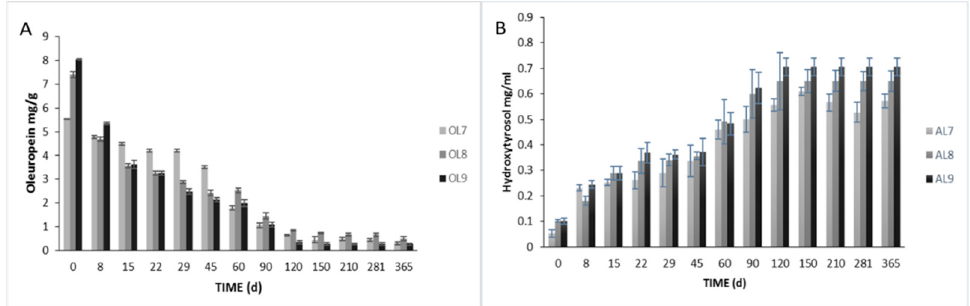
Figure 4. Evolution of oleuropein ( A ) and hydroxytyrosol ( B ) during spontaneous (7), inoculated (10% NaCl) (8), and inoculated (7% NaCl) (9) fermentation of Cypriot green cracked table olives. Results are expressed as means (mg/g or mg/mL) and standard deviations at different times of fermentations.